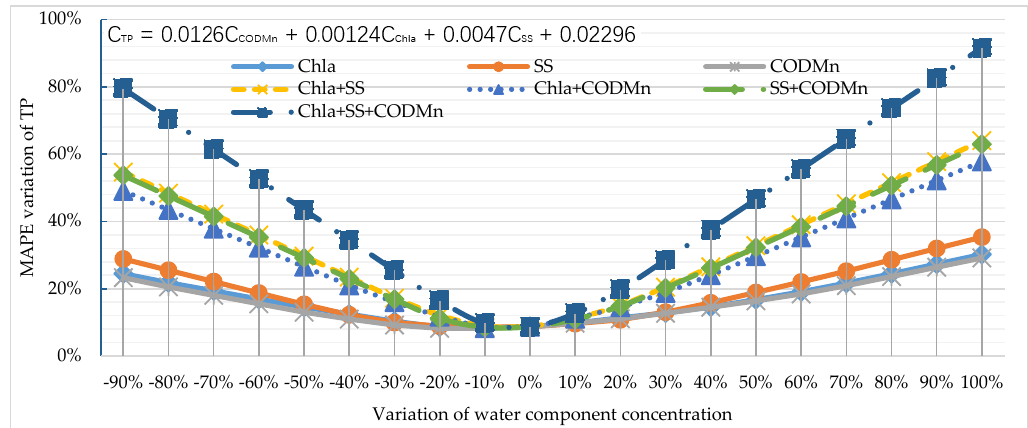
Figure 16. The mean absolute percentage error (MAPE) analysis of the TP retrieval results.